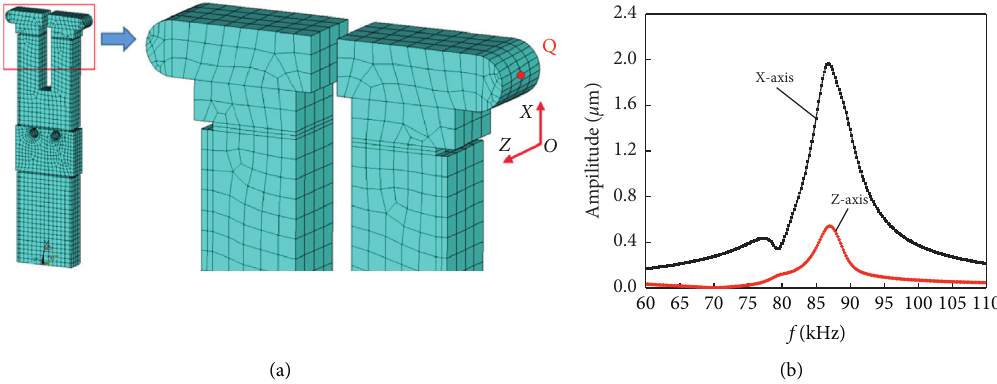
Figure 9: Amplitude-frequency curve. (a) The observation point Q. (b) Amplitude-frequency curve on x - and z